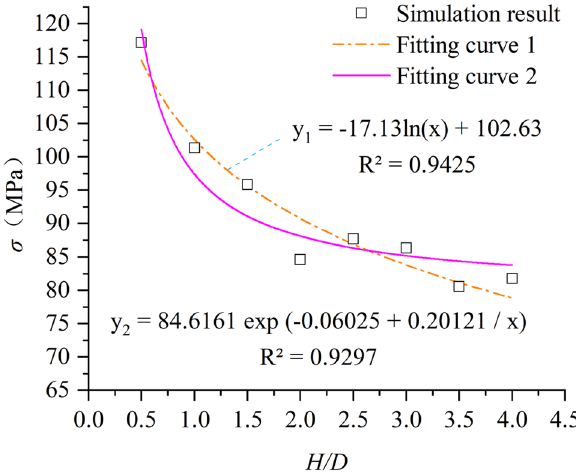
Figure 6. Size effect of compressive strength of intact rock